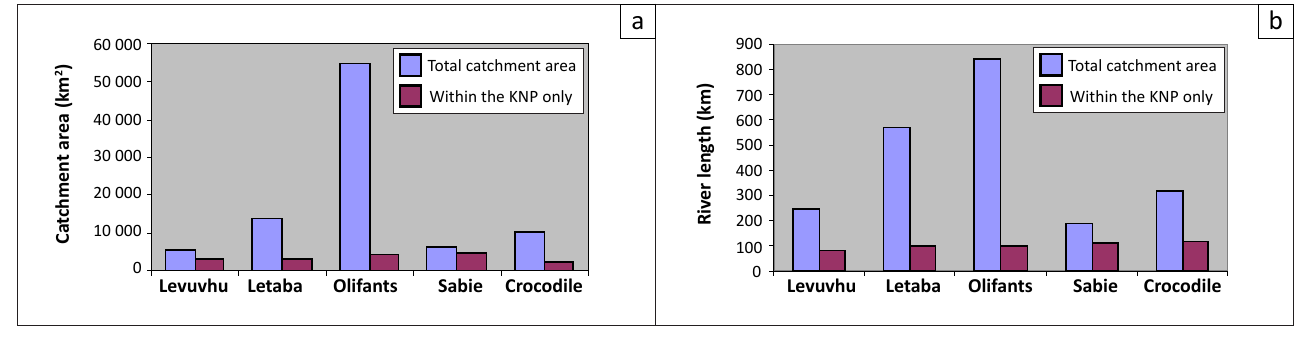
FIGURE 3: A comparison of (a) total catchment areas and (b) river lengths of the five perennial river systems found within the KNP (from Pollard, S.R. & Du Toit, D., 2007, ‘Guidelines for Strategic Adaptive Management: Experiences from managing the rivers of the Kruger National Park, South Africa’, IUCN/ UNEP/GEF Project No. GF/ 2713- 03-4679, Ecosystems, Protected Areas and People Project, Planning and managing protected areas for global